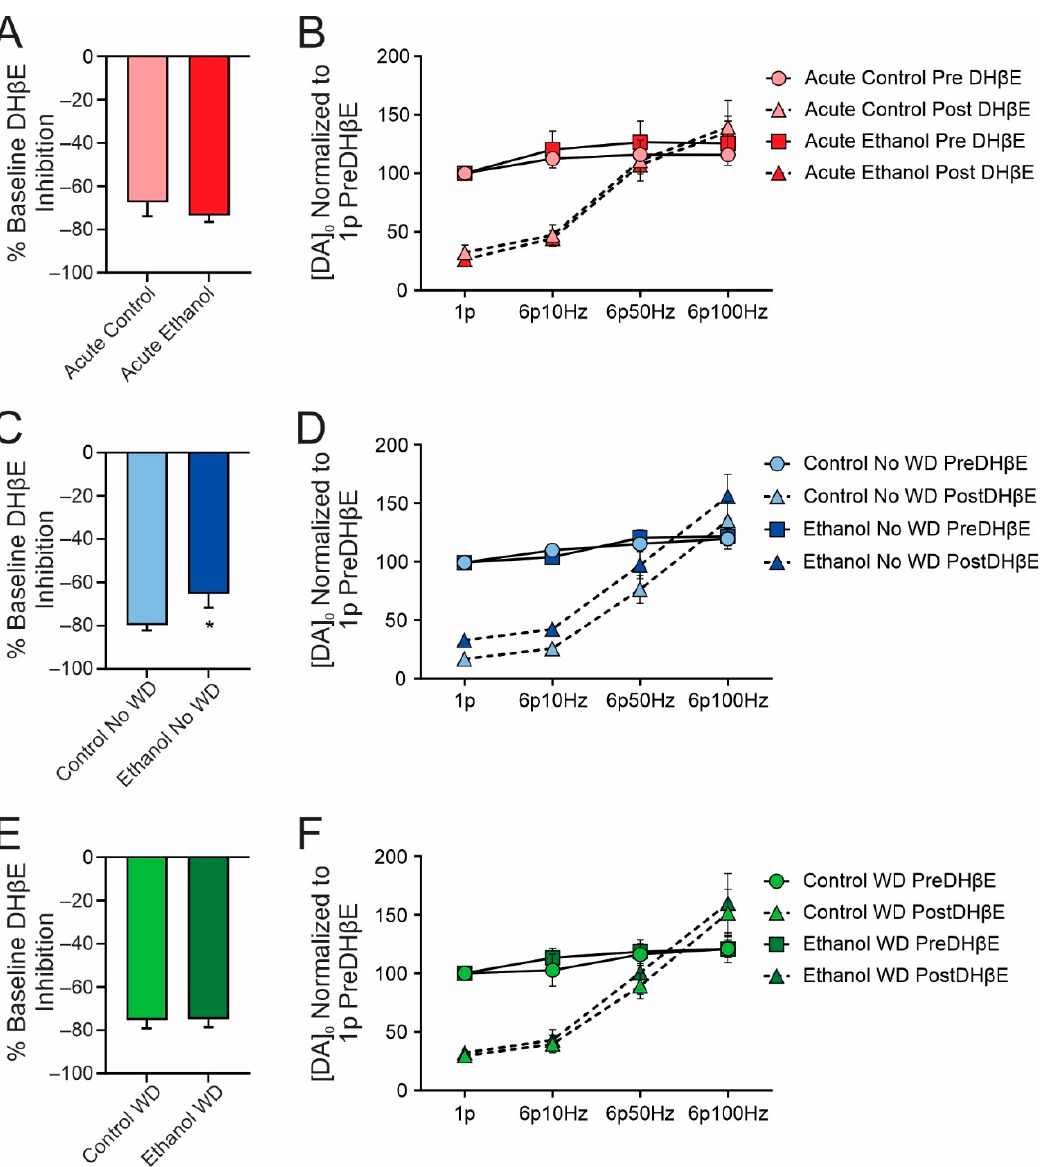
Figure 5. Chronic two-bottle choice ethanol consumption decreases the cholinergic contribution to dopamine release. One day of two-bottle choice ( A ) did not alter dopamine release regulation by the β 2-containing nAChR antagonist, DH β E (1 µM), nor did it alter tonic or phasic dopamine release ( B ). In contrast, chronic two-bottle choice drinking resulted in a decreased inhibition of dopamine release by DH β E ( C ). Phasic release in this group was similar to controls ( D ). These effects were reversed following one week of WD ( E , F ). n = 5–9 slices per group from 5–7 mice per treatment group. * p < 0.05.